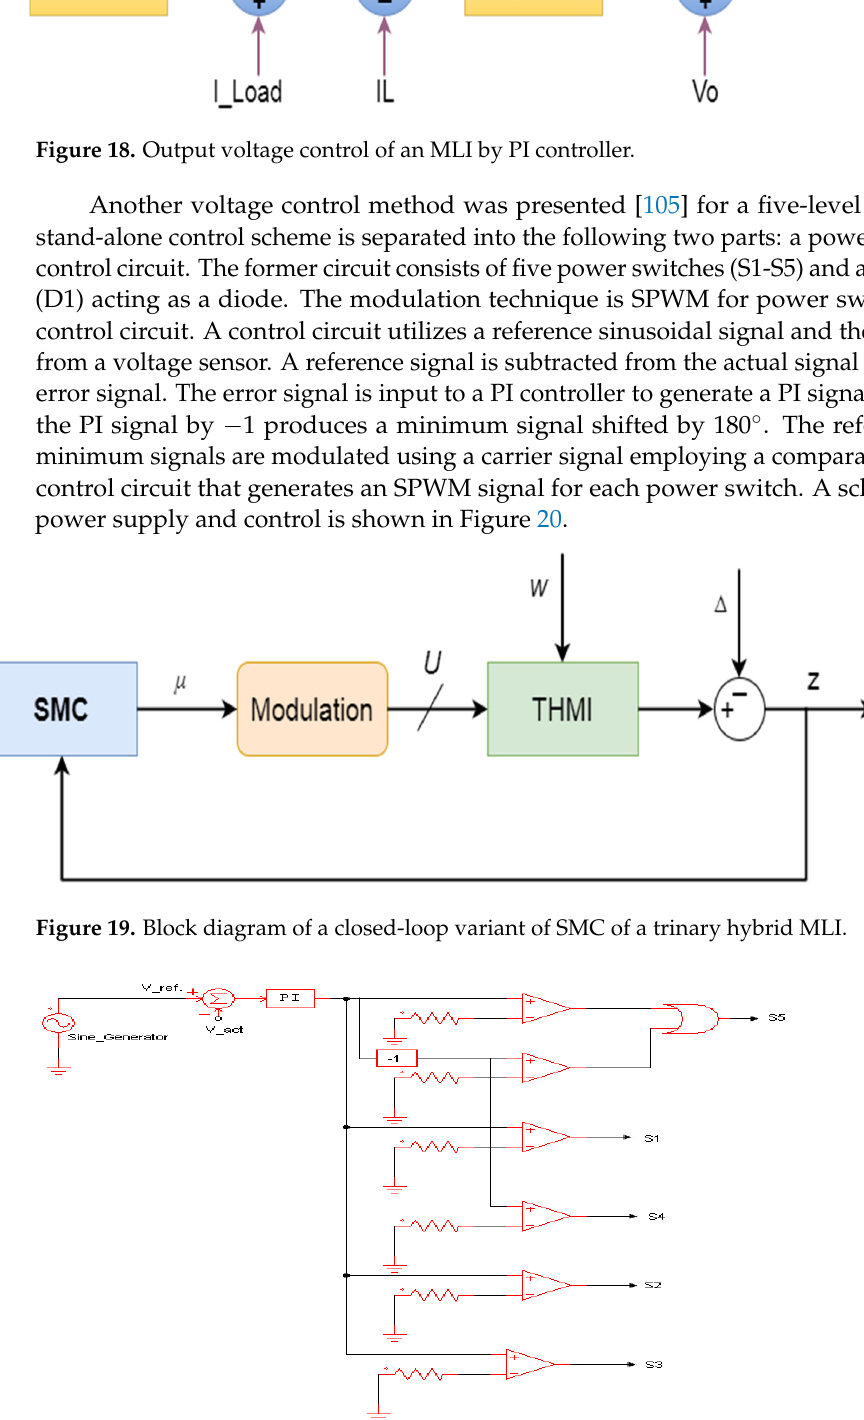
16 of 26 Figure 17. Voltage control for a T-MLI with a RES system. 𝑒 ( 𝑡 ) = 𝑆𝑃 − 𝑃𝑉 (6) 𝑢 ( 𝑡 ) = 𝑒 ( 𝑡 ) (cid:3400) 𝐾𝑃 + (cid:3012)(cid:3010) (cid:3021)(cid:3010) (cid:1516) 𝑒 ( 𝑡 ) 𝑑𝑡